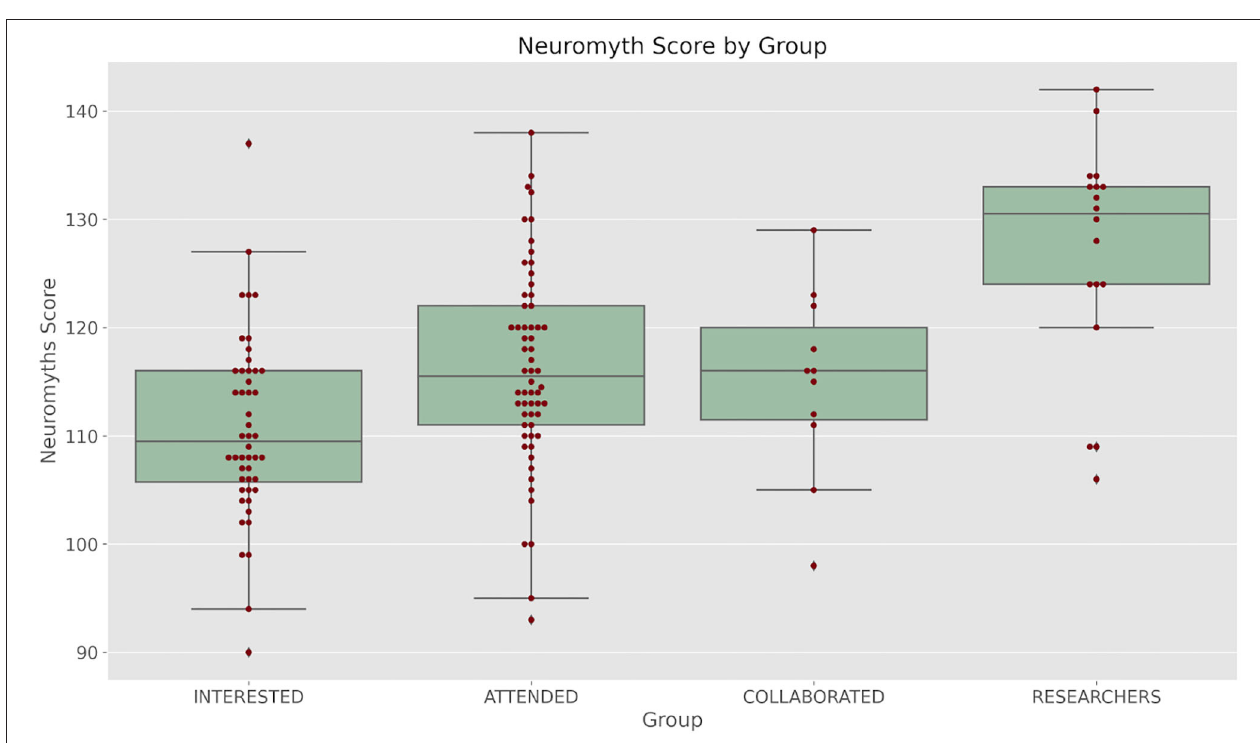
FIGURE 1 | Boxplots showing the distributions of Neuromyth scale scores: INTERESTED refers to a group of teachers not related to our courses and stays. ATTENDED refers to a group of teachers that have participated in the regular course relating Cognitive Science and Education. COLLABORATED refers to those teachers that besides taking part in our course have done or are doing a research stay at our lab. RESEARCHERS Refers to Master students, PhD students or researchers from our lab. See the text for further